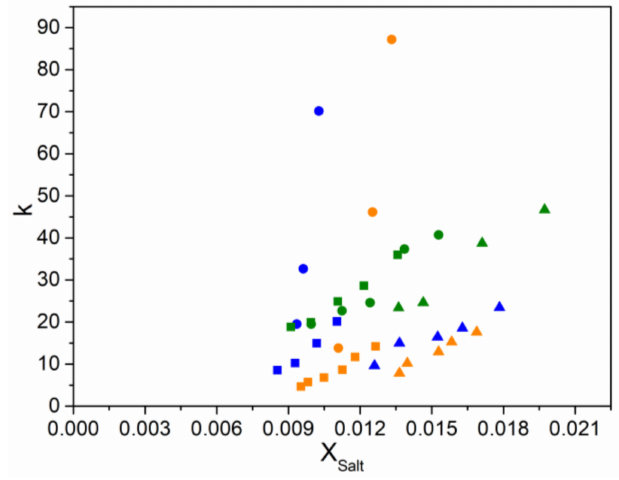
Figure 3. Polymer distribution coefficients for systems with Pluronic L64 + water + sodium sulfate at pH ( • ) 5.0, ( • ) 7.5, and ( • ) 10.0; Pluronic L64 + water + sodium citrate at pH ( ■ ) 5.0, ( ■ ) 7.5, and ( ■ ) 10.0; Pluronic L64 + water + sodium tartrate at pH ( ▲ ) 5.0, ( ▲ ) 7.5, and ( ▲ ) 10.0.